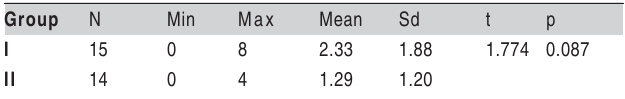
Table 2 - Mean of trace penetration measure in mm after clearance (p<0.05).